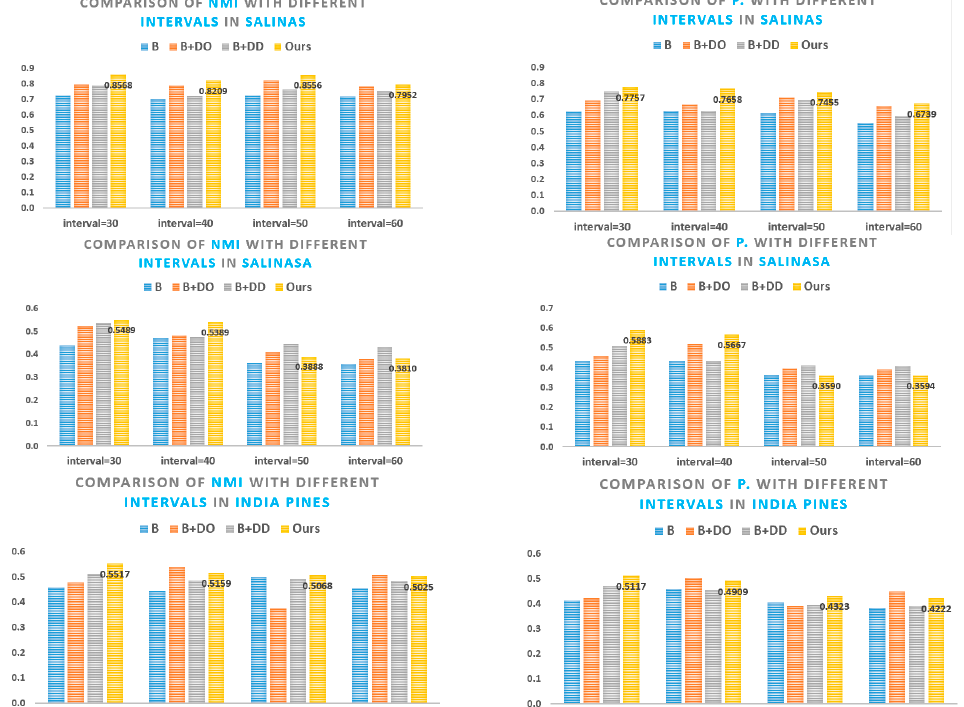
Figure 4. Classification results in different sampling interval.